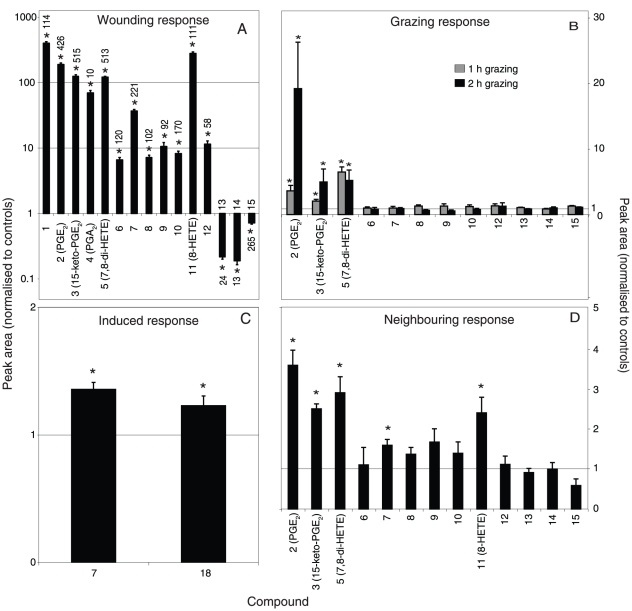
Metabolic response of Gracilaria vermiculophylla analysed by LC/MS.A: metabolites up- and down-regulated followed by mechanical simulation of herbivory. B: effects of Idotea baltica feeding on the expression of metabolites 2 (PGE2), 3 (15-keto-PGE2), 5 (7,8-di-HETE), 6 - 10 and 12-15. C: metabolites up-regulated followed by exposure to extracts from mechanically wounded algae. D: neighbouring effects of local mechanical wounding on the expression of metabolites 2 (PGE2), 3 (15-keto-PGE2), 5 (7,8-di-HETE), 6–10, 11 (8-HETE) and 12–15. Metabolic responses to the treatments are shown as peak areas normalised to corresponding controls. *Significant difference from the control (see the text for details). Data are means+SE, n = 10 (A), 8 (B, D) or 7 (C). Numbers at the end of the bars in A are the relative peak area for the metabolites up and down-regulated followed by simulation of herbivory. Note logaritmic scale in A.